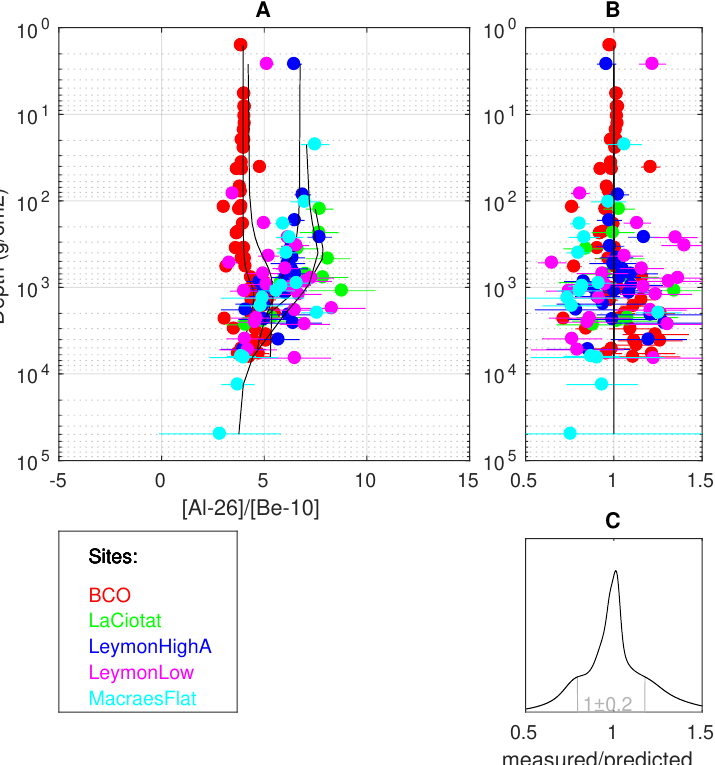
Figure 7. Subsurface 26 Al/ 10 Be ratios. ( A ) Plot of 26 Al/ 10 Be concentration ratios shown in Balco [17] (coloured circles with error bars) and cross sections predicted by P_mu_total_alpha1.m (black lines), also from Balco [17]. All concentration ratios (measured) scaled to their predicted ratios ( B ) are plotted as a camel-plot with 68% of its area at ∼ 100 ± 20% ( C